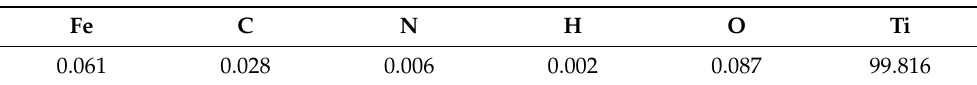
Table 2. Chemical composition